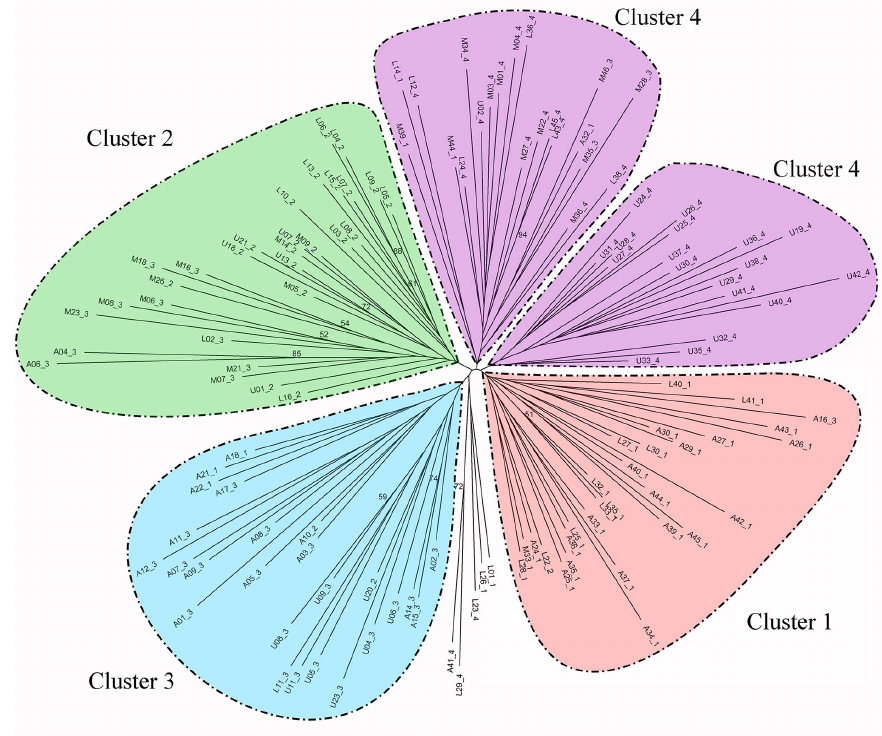
Figure 4. Neighbor-Joining unrooted dendrogram of “yerba mate” individual plants based on ISSR derived genetic distances (Dice distances). Individuals are indicated by their internal number followed by the number of the corresponding DAPC genetic cluster (1-4). Dotted lines circumscribe groups in rough correspondence with DAPC clusters. Bootstrap values ≥ 50 % are shown on